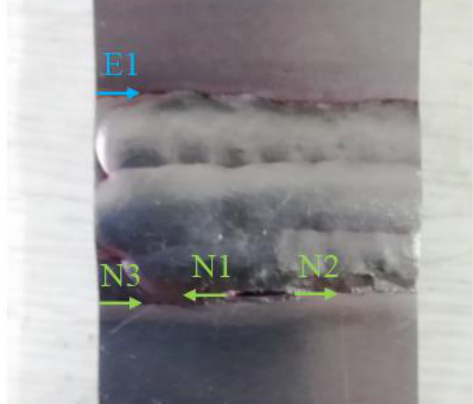
Figure 10. The illustration of crack initiation positions and growth direction.